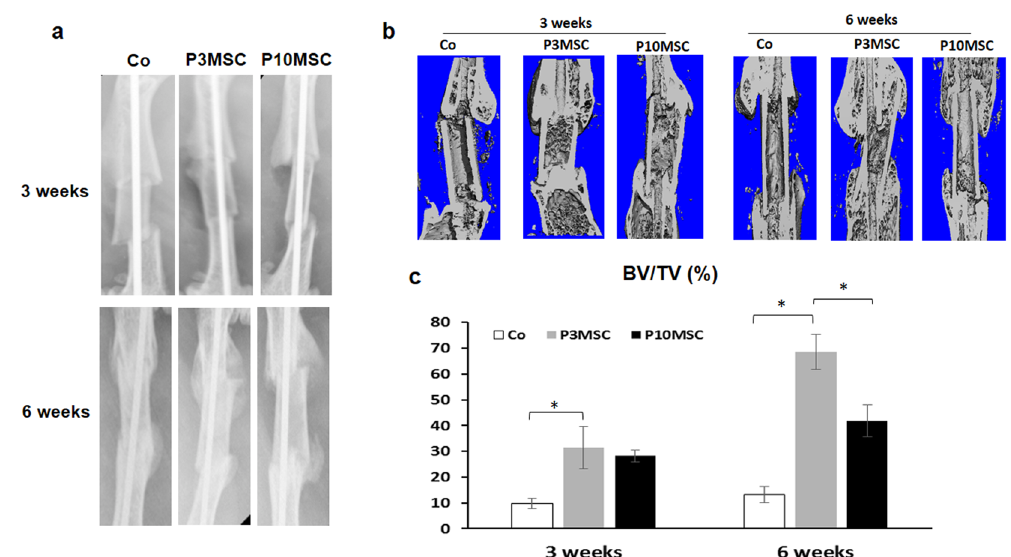
Figure 4. Enhanced callus formation in both MSC sheets wrapped allografts at 3 and 6 weeks post-surgery. ( a ) Representative X-ray images of allograft healing at 3 and 6 weeks post-surgery. ( b ) Representative M icro-CT images (cross-section) of allograft healing at 3 and 6 weeks post-surgery. ( c ) Quantification of the bone volume (BV) over total tissue volume (TV) shows a greater bony callus formation in the P3 MSC sheets groups in comparison to the P10 MSC sheets groups (n = 6). * P <